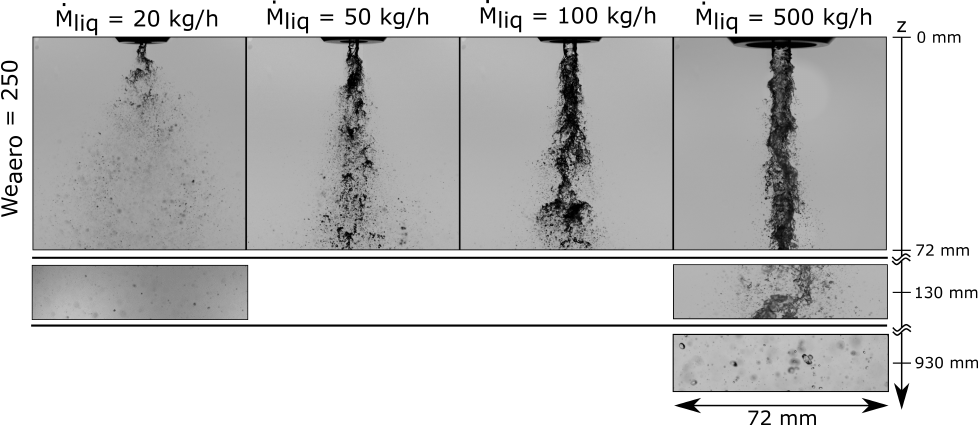
Figure 4. High-speed camera images of primary breakup at We aero = 250 at varying liquid mass flows and different axial positions z = 0, 130, 930